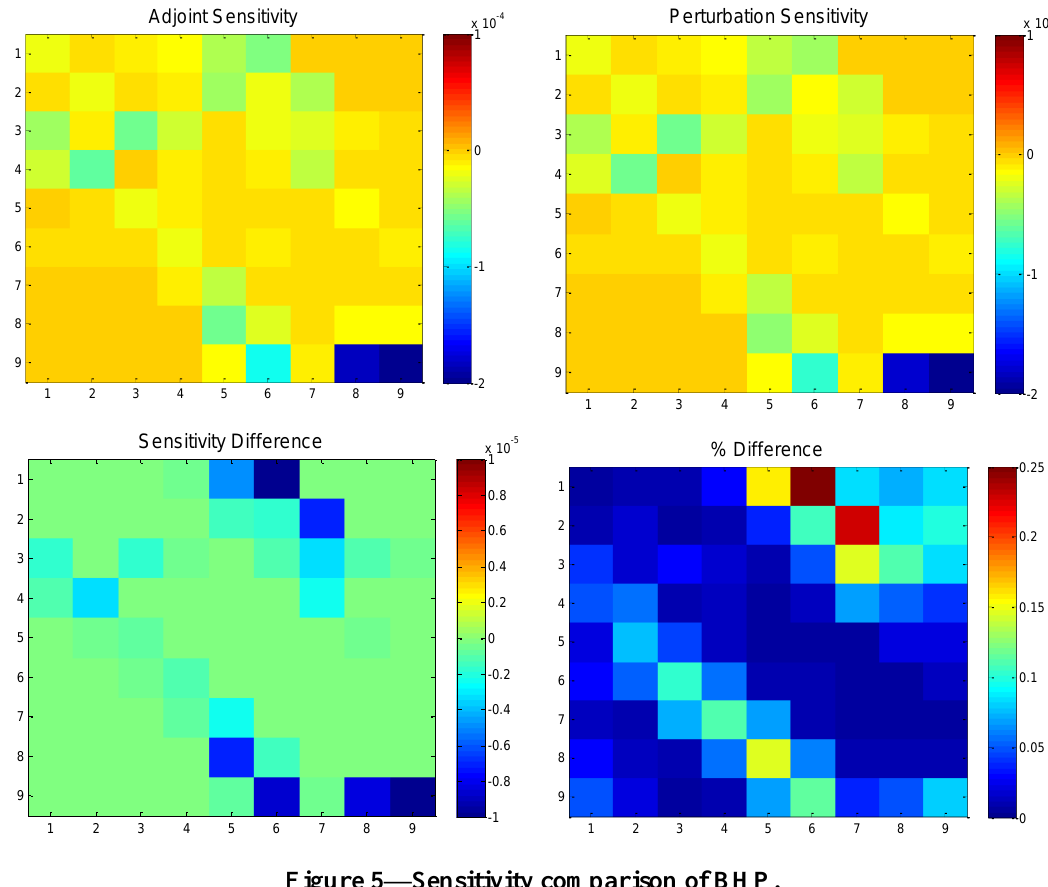
Figure 5—Sensitivity comparison of BHP.